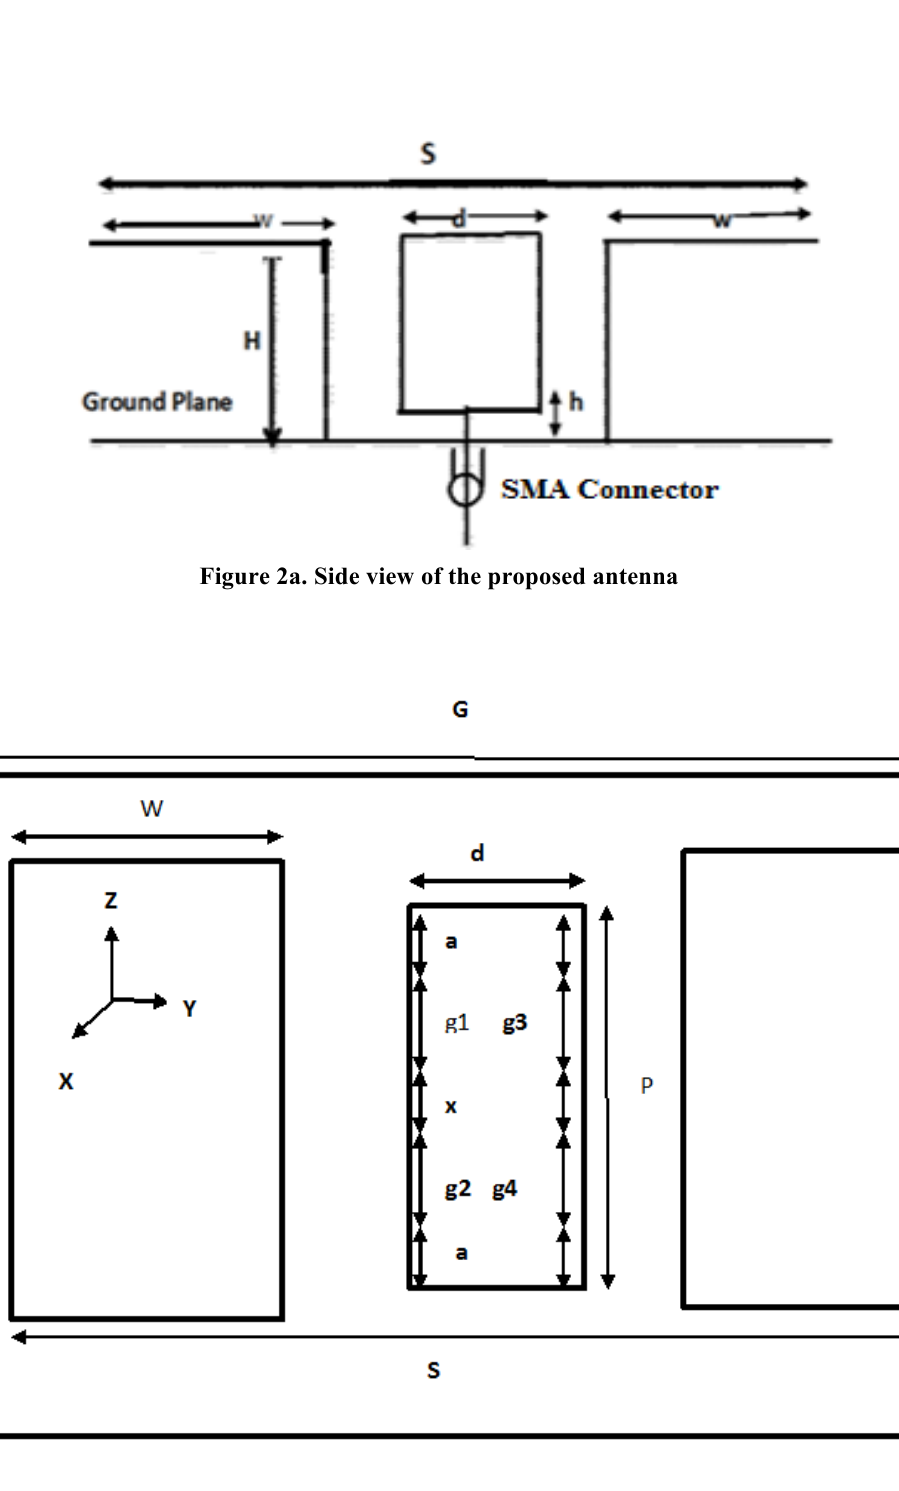
Figure 2b. Top view of the proposed